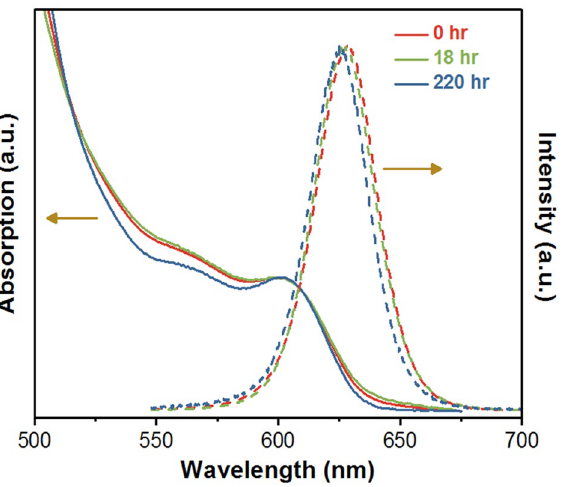
Figure 10. The absorption and PL spectra of QDs vs. test time tested under ambient